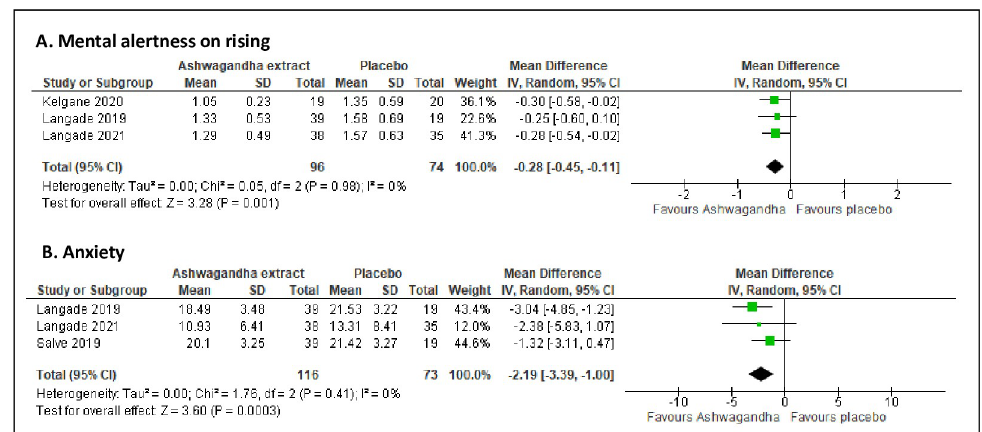
Fig 7. Forest plots of Ashwagandha versus placebo on (A) mental alertness on rising, (B) anxiety.